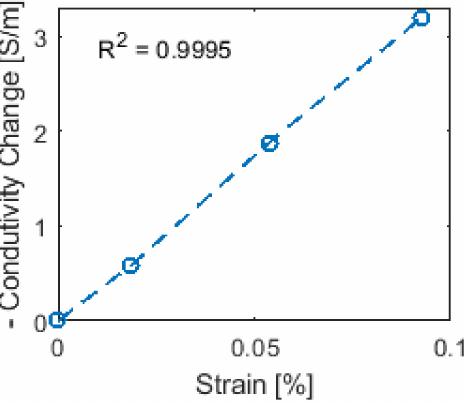
Figure 9. The vertical struts’ average conductivity change from sensing mesh ERT results were calculated and plotted against the strain gage measurements of the PVC plate. Conductivity decreased as greater tensile strains were